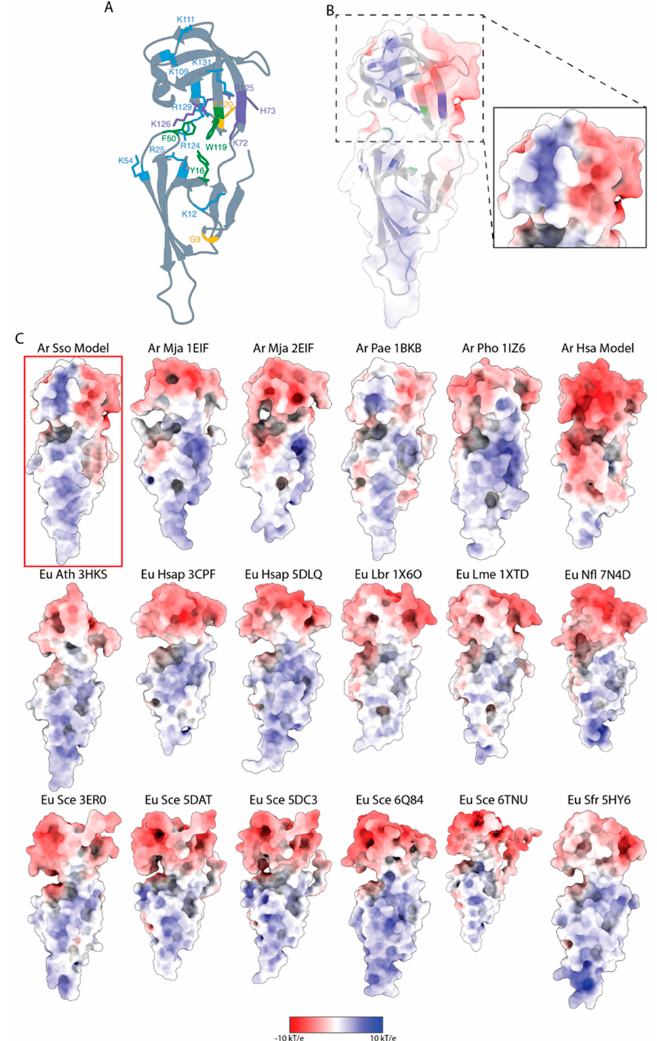
Figure 5. IF5A RNA-binding and cleavage structural characteristic. ( A ) 3D ribbon illustration of S. solfataricus aIF5A where basic residues (i.e., K12, R25, K54, K109, K111, R124, R129, and K131), aromatic residues (i.e., Y16, F50, W119), common residues (i.e., K72, H73, R125, and K126) identified from the pairwise alignment with Halobacterium sp. NRC-1 amino acid sequence (reported from the work by Wagner et al. [25]) and hypothetical residues (i.e., G9 and E120) involved in RNAse activity (reported from the work by Wagner et al. [25]) are depicted in light blue, green, purple and yellow, respectively. ( B ) S. solfataricus aIF5A 3D ribbon illustration with electrostatic potential mapped on molecular surface. The ribbon structure depicts the essential basic and aromatic residues in blue and green, respectively. The electrostatic potential projected on the molecular surface of the OB-Fold region of S. solfataricus aIF5A is shown in the inset. ( C ) Electrostatic potentials are represented by the color of the molecular surfaces of several archaea and eukaryotic IF5A proteins: red is negative, blue is positive, and white is neutral. The model structure of S. solfataricus aIF5A is outlined in red. All the structures were refined and utilized to determine the EPS with the ABPS tool applying continuum solvation techniques. All structures were superimposed on S. solfataricus aIF5A to achieve the same spatial orientation. Surface potentials range from − 10.0 kT/e (red) to 10 kT/e (blue). When no PDB code is given, the structure is a model. Ar, Archaea; Eu, Eukarya; Sso, Sulfolobus solfataricus; Mja, Methanocaldococcus jannaschii; Pae, Pyrobaculum aerophilum; Pho, Pyrococcus horikoshii; Hsa, Halobacterium sp. NRC-1; Ath, Arabidopsis thaliana; Hsap, Homo sapiens; Lbr, Leishmania braziliensis; Lme, Leishmania Mexicana; Nfl, Naegleria fowleri; Sce, Saccharomyces cerevisiae; Sfr, Spodoptera frugiperda